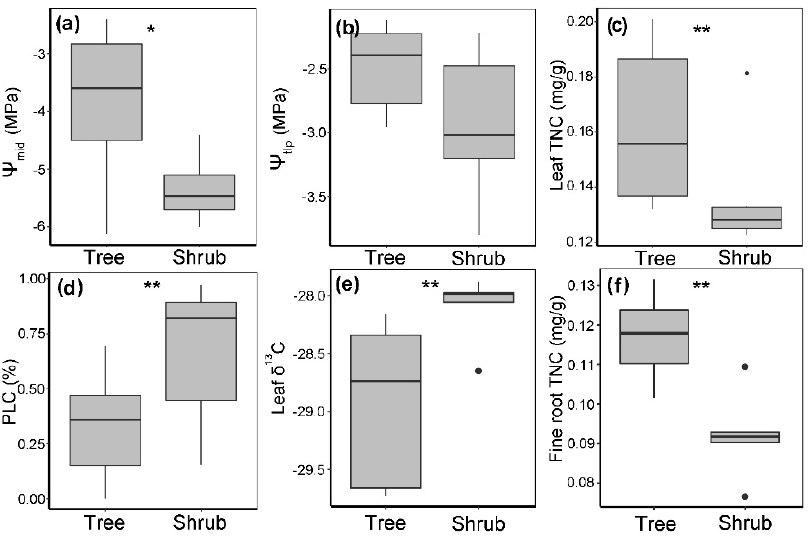
Figure 3. Box plots show the difference between drought stress, tolerance, and nonstructural carbo- hydrate performance of Quercus mongolica trees and shrubs. We report ( a ) midday leaf water poten- tial ( Ψ mid ) and ( d ) percentage loss of stem hydraulic conductivity (PLC) as the drought stress that plants are bearing; ( b ) leaf turgor loss point ( Ψ tlp ) and ( e ) leaf δ 13 C as plant drought tolerance ability; and plant ( c ) leaf and ( f ) fine root total nonstructural carbohydrate (TNC) of Q. mongolica individu- als. The horizontal lines represent the 25%, 50%, and 75% quantiles. The vertical lines show the 5% and 95% quantile. The stars show the results of a Wilcoxon rank-sum test: **, p < 0.05; *, p < 0.1.